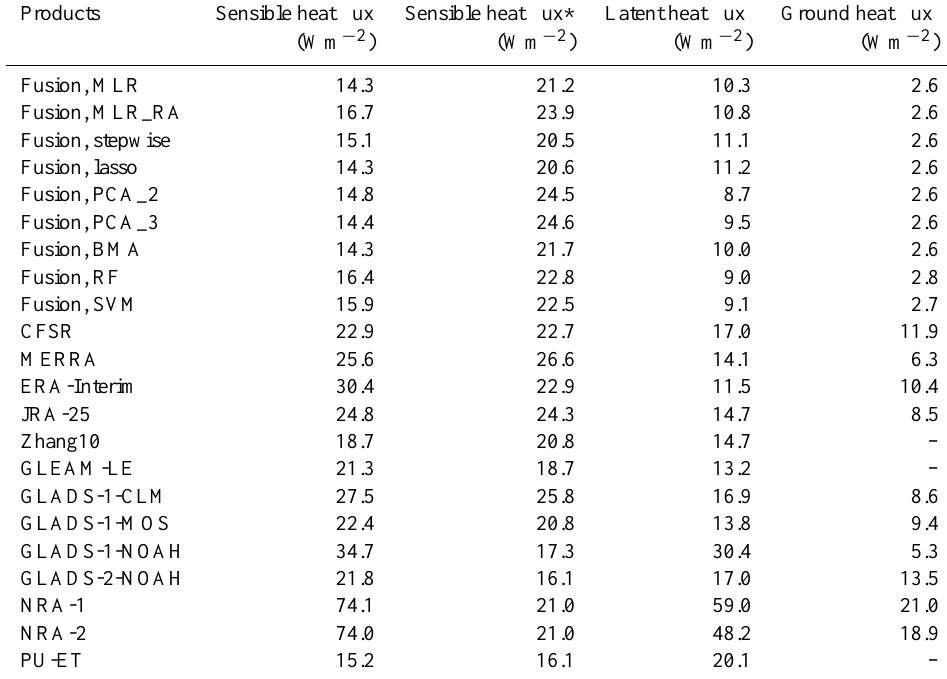
Table 5. Comparison of the cross-validation results of the surface energy budget from the fused data, other data fusion approaches (MLR_RA: MLR using reanalysis data sets; stepwise: stepwise regression; lasso: adapted lasso regression; PCA_2: principle analysis regression using first two principle components; PCA_3: principle analysis regression using first three principle components; BMA: Bayesian model aver- aging; RF: random forest; SVM: supported vector regression), reanalysis, and remote-sensing data sets (* denotes results from fusing or calibrating the sensible heat flux from multiple data sets or single data set